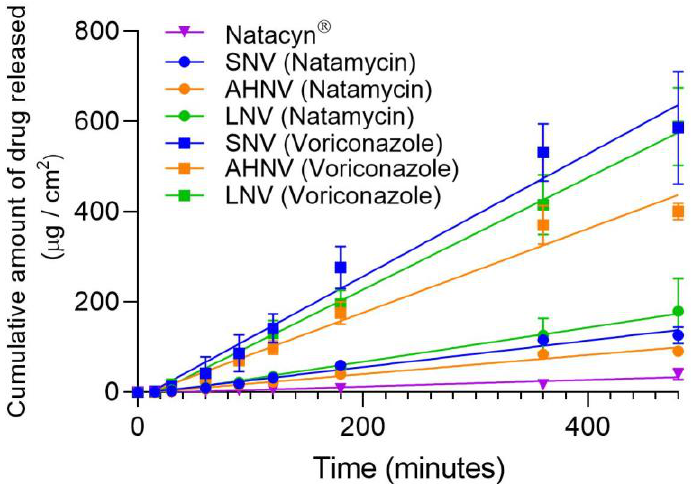
Figure 7. In vitro release profiles of natamycin/voriconazole formulations. All data were fitted to zero-order kinetics.